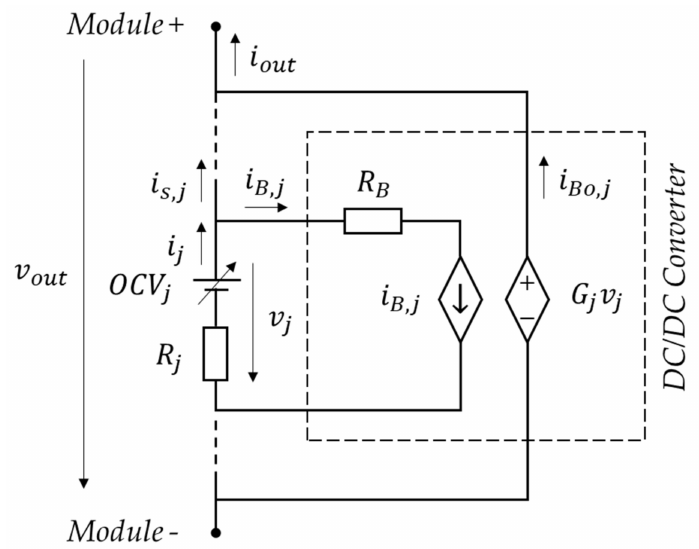
Figure 6. EECM of the 8S battery module and the DC/DC converter of the CPC balancing